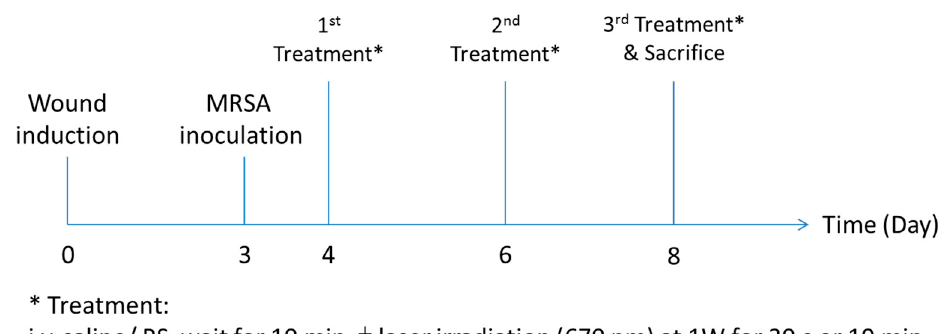
Figure 2. Timeline for the intravenous treatment .